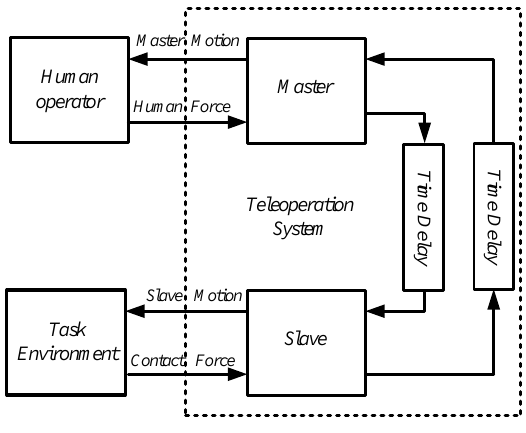
Figure 1. A general framework of bilateral teleoperation